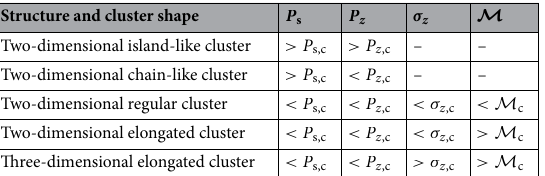
Structure and cluster